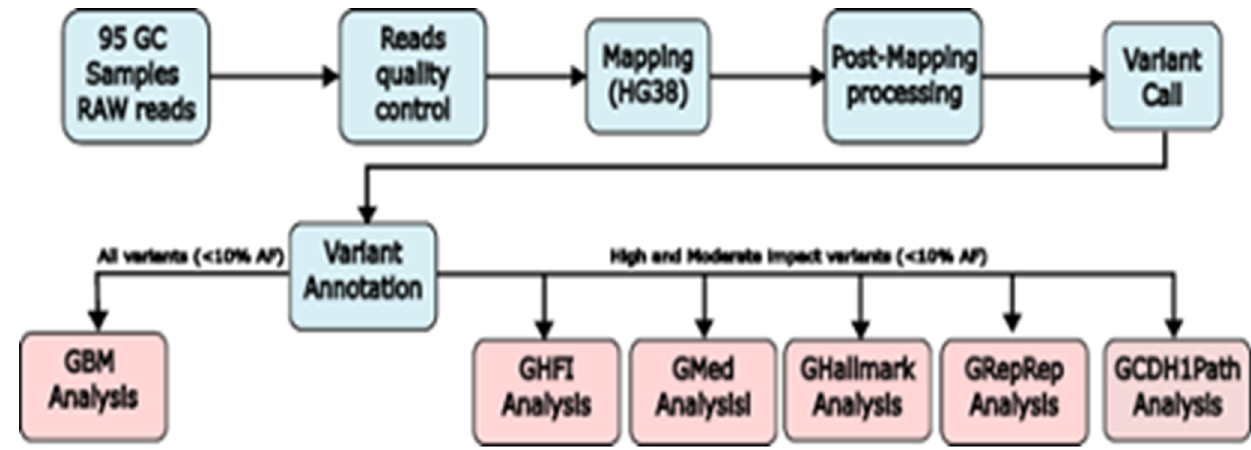
Figure 1. Schematic flow chart of the procedures applied.